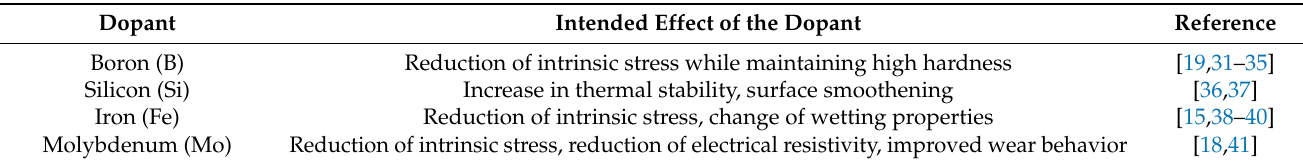
Table 1. Effect of dopants and selected